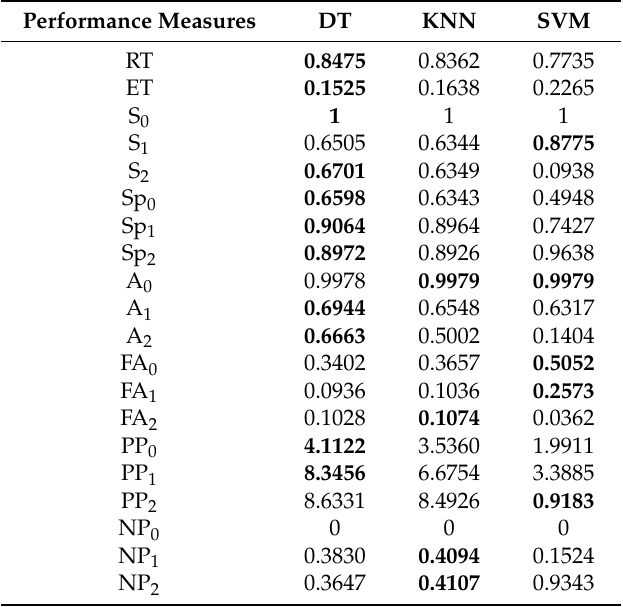
Table 9. Comparison of eight performance measures for the three classifiers using signal block 1, for dt = 4. The best performance results are highlighted in